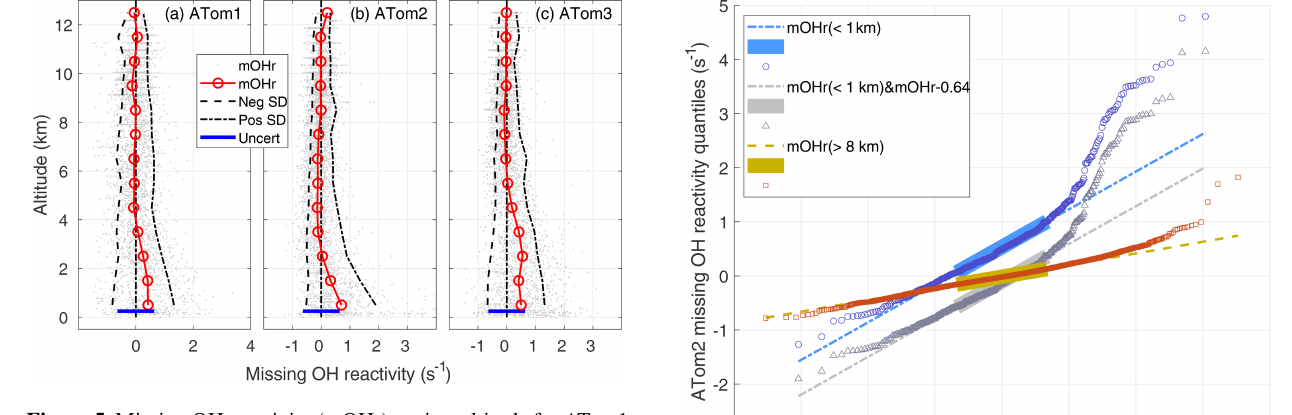
Figure 5. Missing OH reactivity (mOHr) against altitude for ATom1 (August), ATom2 (February), and ATom3 (October). Gray dots are the OH reactivity calculated by subtracting calculated OH reactiv- ity from measured OH reactivity. Median missing OH reactivity be- low 1km altitude (red circles and lines) is comparable to the abso- lute uncertainty in the missing OH reactivity (blue bar, 95% con- fidence). The standard deviation of the negative missing OH reac- tivity data for each 1km of altitude (left of the zero line) and of the positive missing OH reactivity data (right of the zero line) are shown at the 95% confidence level and indicate the skewness in the missing OH reactivity data distribution below 2–4km altitude.